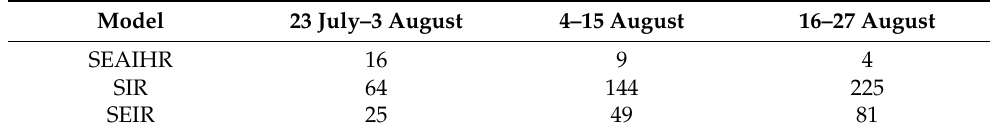
Table 11. Comparison of MSFE of three